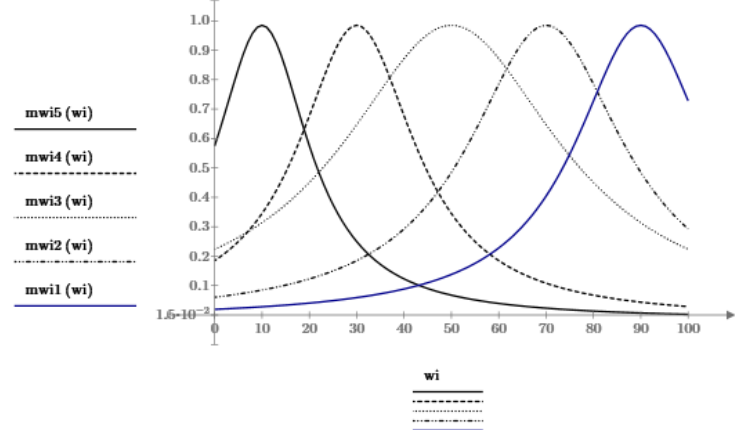
The graph of the membership function of WI